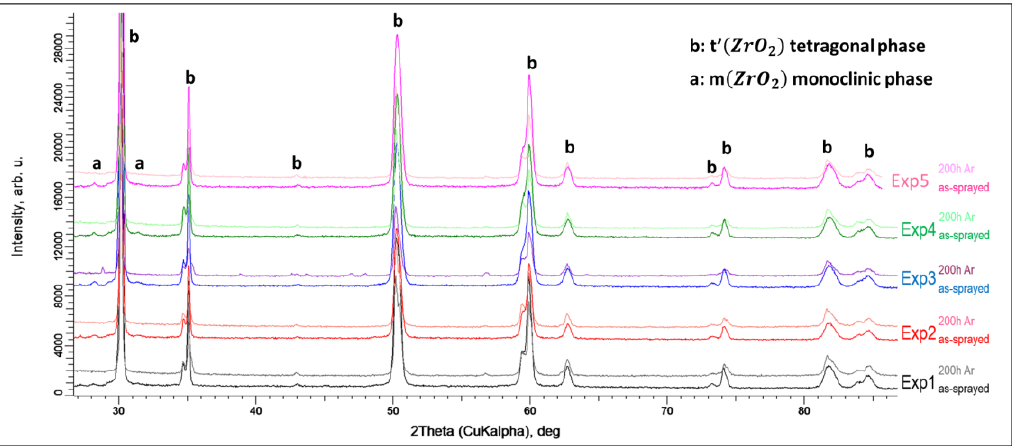
Figure 8. Crystallite phase analysis performed by XRD for all five coatings before and after heat treatment showing no phase change.